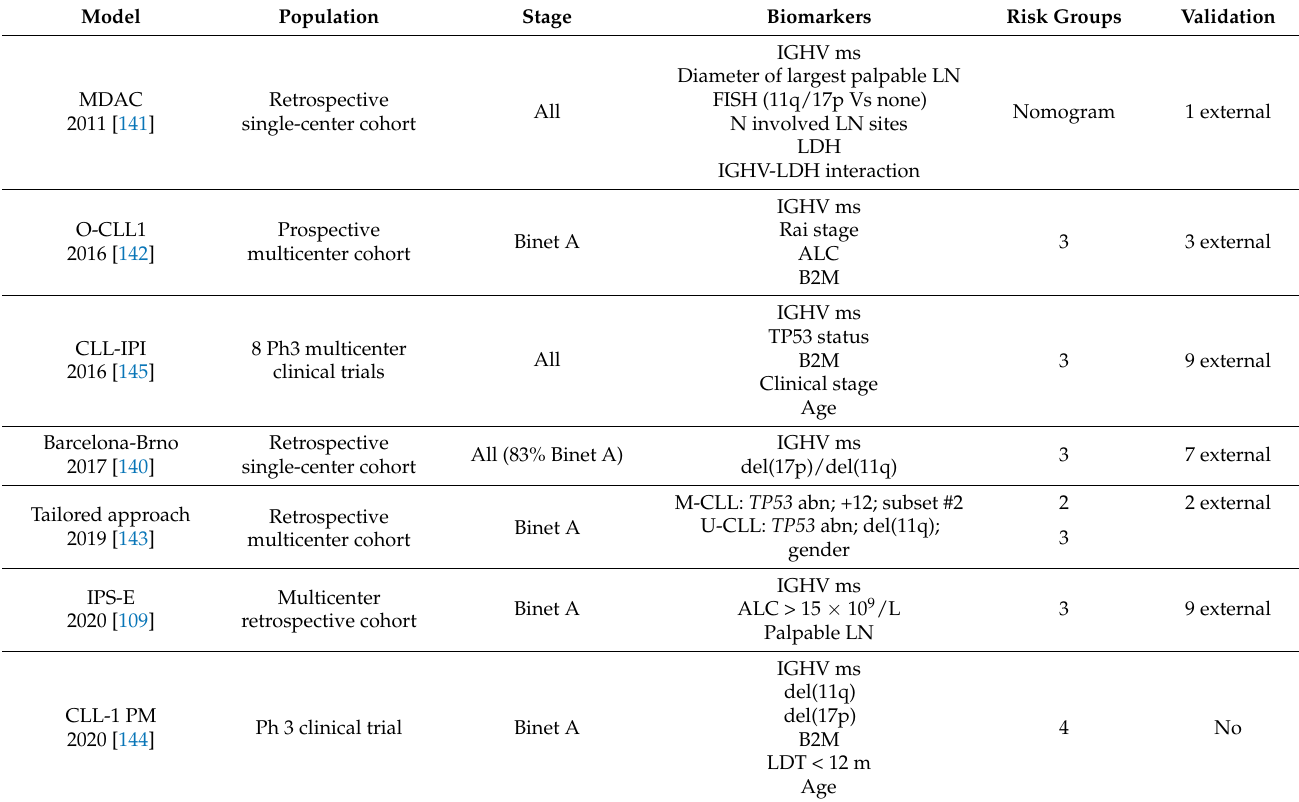
Table 2. Selection of prognostic models validated to predict time to first